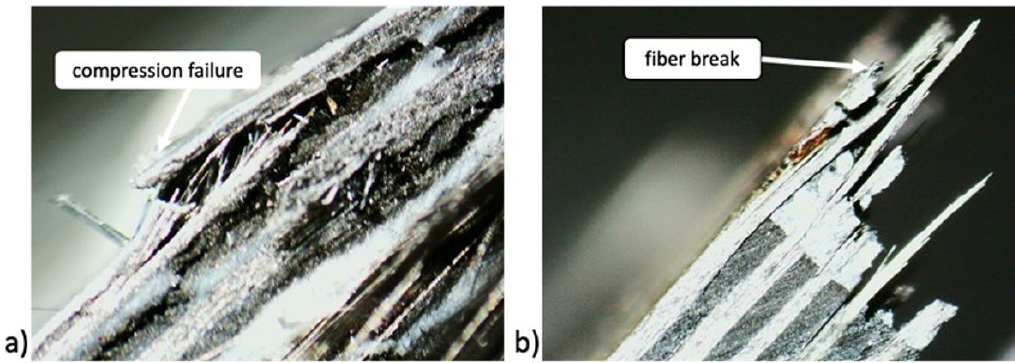
Figure 7. Types of fractures occurring: a) in thermoplastic laminates; b) and in